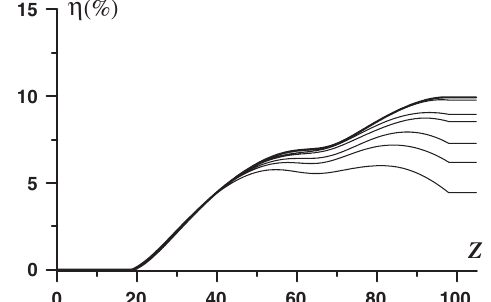
FIG. 14. FEL with a strong conventional guide field. Dependence of electron efficiency on longitudinal coordinate (for parameters given in Fig. 13) for the beam fractions with different initial parasitic transverse velocity at the entrance of the interaction space. The maximum initial parasitic transverse velocity equals 15% of the operating transverse velocity.